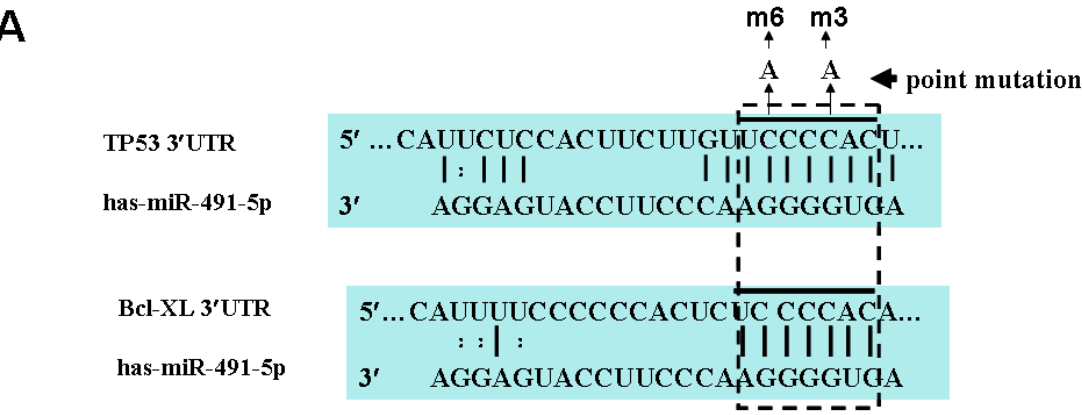
Figure 4. The rescued effects of point mutations at the seed regions of TP53 and Bcl-XL, the targeted genes by miR491-5p. ( A ) Two single C A point mutations were generated at 3rd and 6th nucleotide of the seed region on the 3'UTRs of the targeted genes TP53 and Bcl-XL. These mutants were named as EGFP-53m3, EGFP-53m6, EGFP-XLm3 and EGFP-XLm6; ( B ) Flow cytometric analysis on the expression of EGFP gene cassette carrying wild type TP53 3'UTR (53-UTR) or its mutants (53-m3 and 53-m6). About 4 μ g of synthesized miR491-5p was individually cotransfected with 1 μ g of pEGFP-53-UTR or its mutants into SW1990 cells. Data represents as mean ± SD from three to four independent experiments. The difference was calculated by student’s t test. Significant difference was indicated as p < 0.05, while no significant difference was indicated as p > 0.05; ( C ) Flow cytometric analysis on the expression of EGFP gene cassette carrying the wild type Bcl-XL 3'UTR (XL-UTR) or its mutants (XL-m3 and XL-m6). About 4 μ g of mutants into SW1990 cells. Data represents as mean ± SD from three to four independent experiments. The difference was calculated by student’s t test. Significant difference was indicated as p < 0.05, while no significant difference was indicated as p >